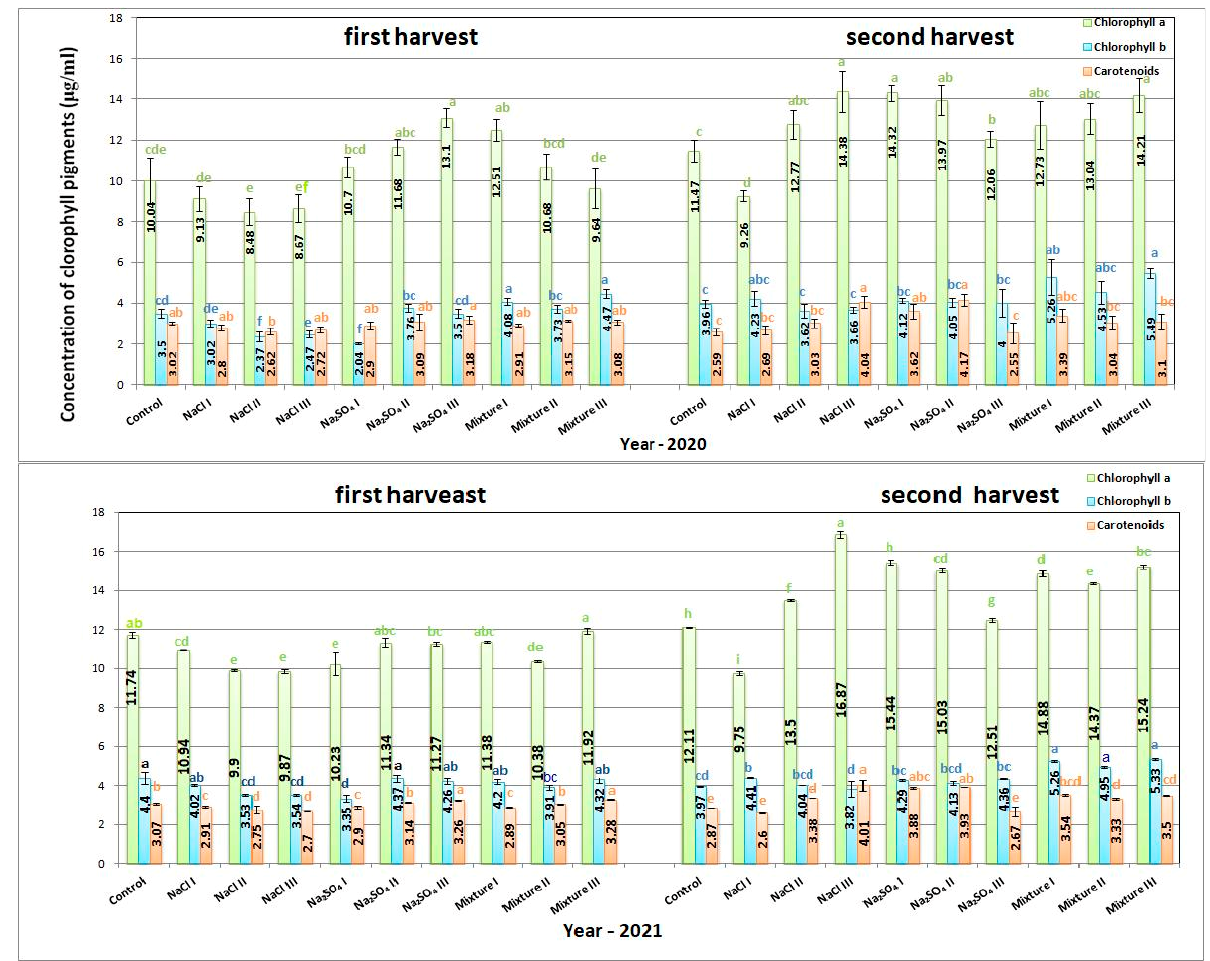
Figure 4. The concentrations of photosynthetic pigments for Nepeta racemosa Lam. in 2020 and 2021, with significant differences at 0.05 level indicated with letters.